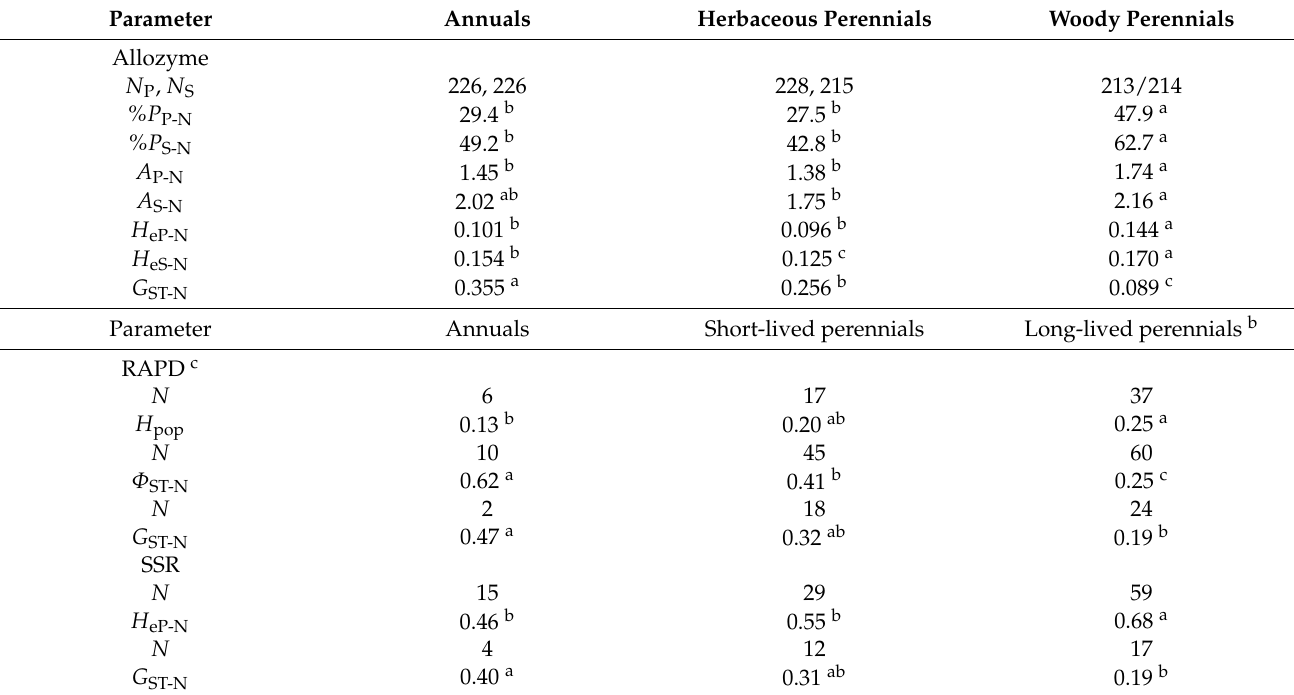
or 27.5; Table 1), and A P-N (1.74 versus 1.45 or 1.38; Table 1). A similar pattern was also found in overall species-level genetic diversity across life forms as measured by H eS - N (0.170 versus 0.154 or 0.125; Table 1), %P S-N (62.7 versus 49.2 or 42.8; Table 1), and A S-N (2.16 versus 2.02 or 1.75; Table 1). Furthermore, the degree of among-population allozyme genetic diversity in trees is substantially lower than in herbaceous perennials or annuals as measured by G ST-N (0.089 versus 0.256 or 0.355; Table 1). A similar pattern is found for DNA-based markers (Table 1). Several factors are suggested to explain the higher in trees. These include a predominantly outcrossing mating system, higher levels of gene flow, longevity, tall statures, low population densities, occurrence in late successional communities, polycarpic nature, larger N e , low linkage disequilibrium, presumably high levels of AGV, a higher basic number of chromosomes, more diversifying selection, or delayed maturity [45,47,48]. Table 1. Mean levels and distribution of allozyme, RAPD, and SSR diversity of plant species representing different life forms (for allozymes from [48] and for RAPDs and SSRs from [49]) a . Parameter